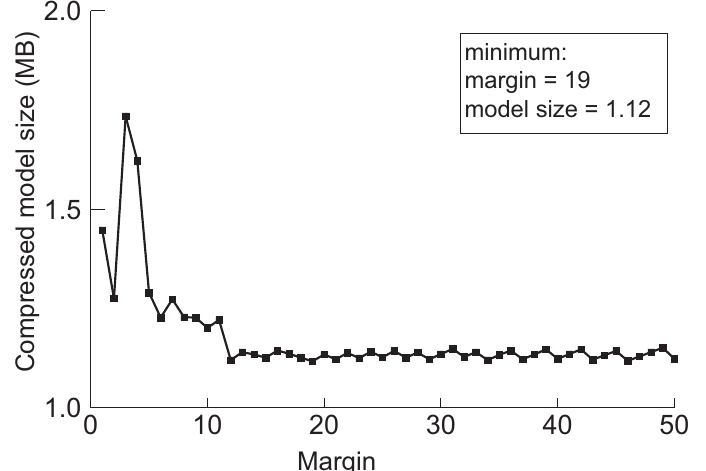
Figure 8. The minimum model sizes derived by the proposed method when the initial margin is varied from 1 to 50 for DenseNet-40 when the target accuracy is